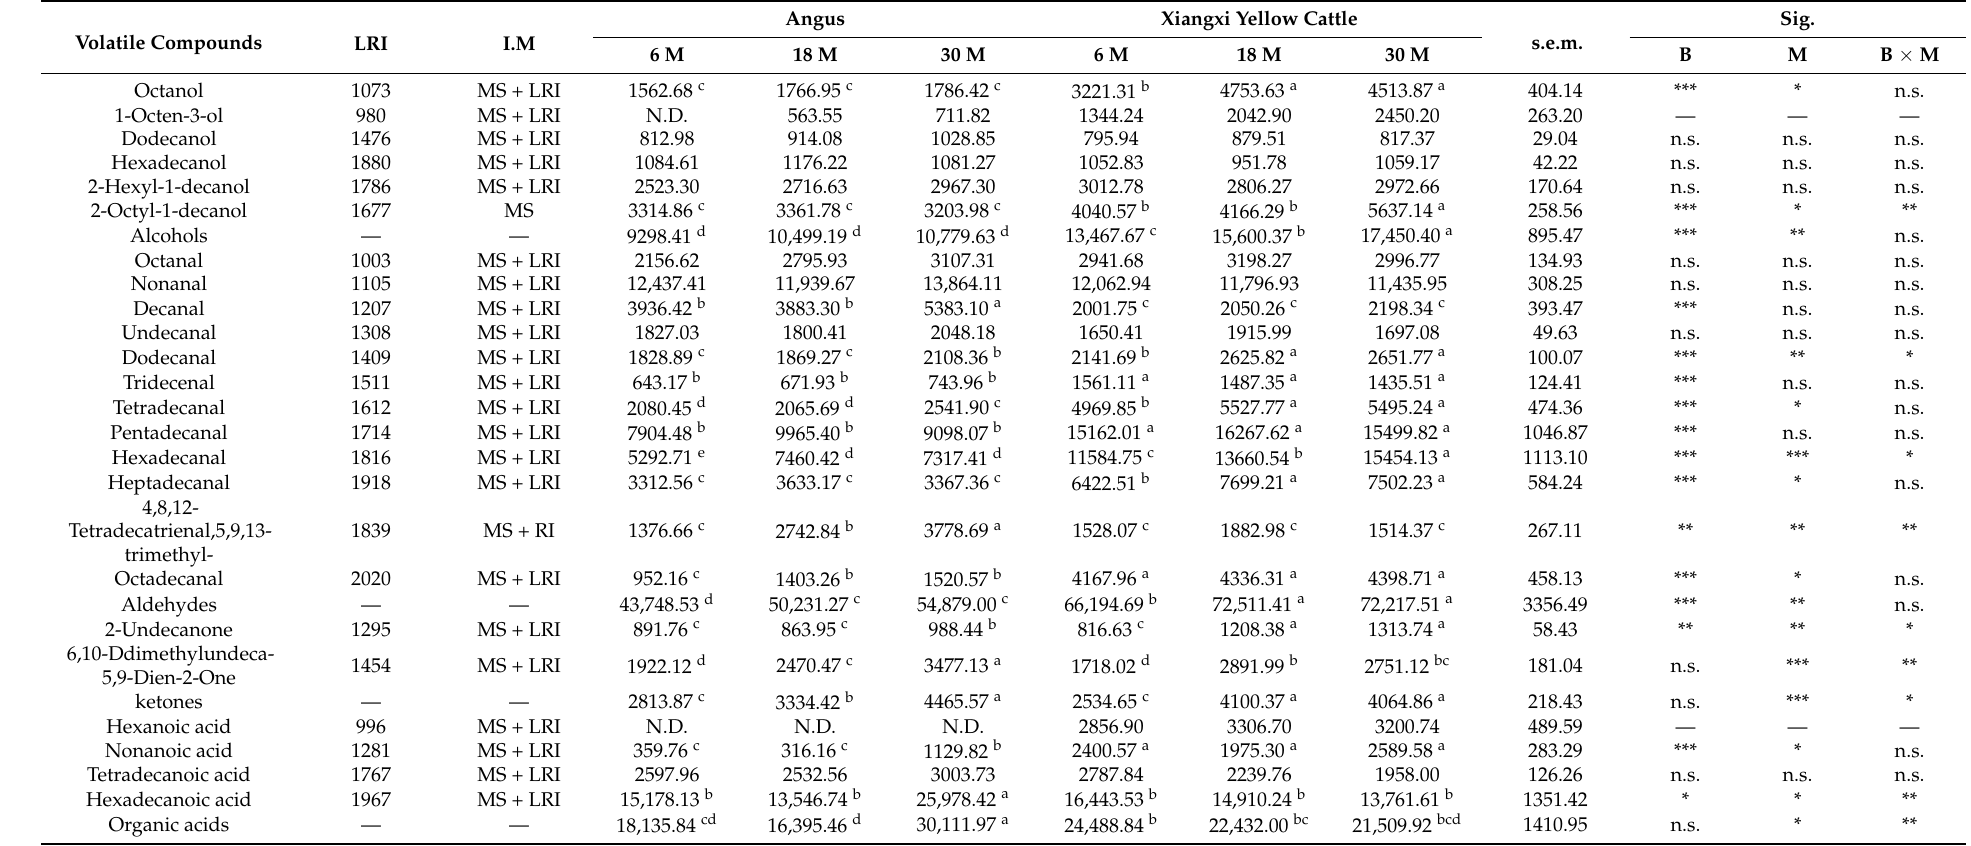
Table 4. The commonly identified volatile compounds (ng/100 g) in LT muscle from Angus and Xiangxi yellow